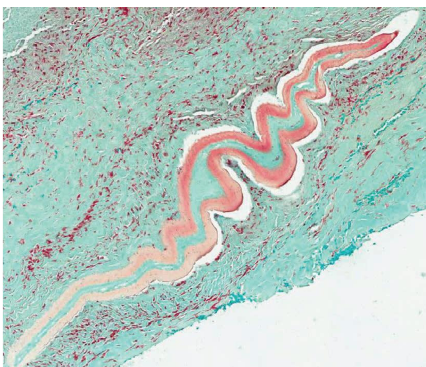
Figure 2: Longitudinal section revealing degenerating Onchocerca lupi nematode encased in infamed, dense fbrous tissue. Lil- lie–Twort Gram stain, original magnifcation ×